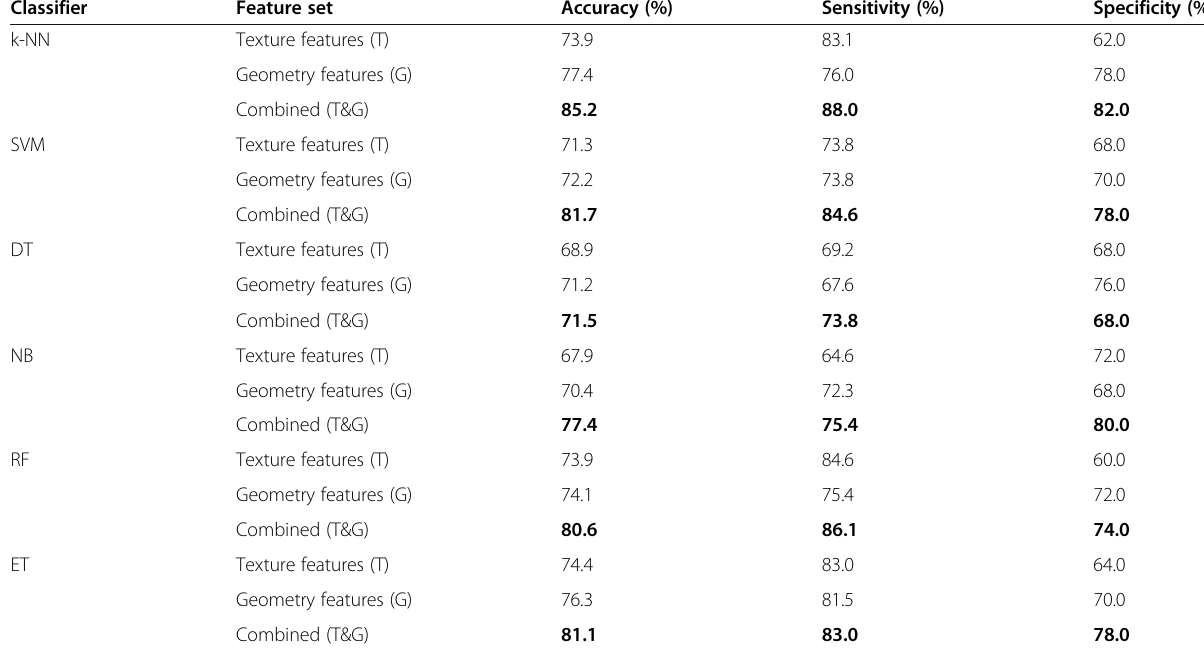
Table 11 Classification results obtained by employing the top 20 texture, top 20 geometric, and top 20 combined texture and geometric features with six different state-of-the-art classifiers